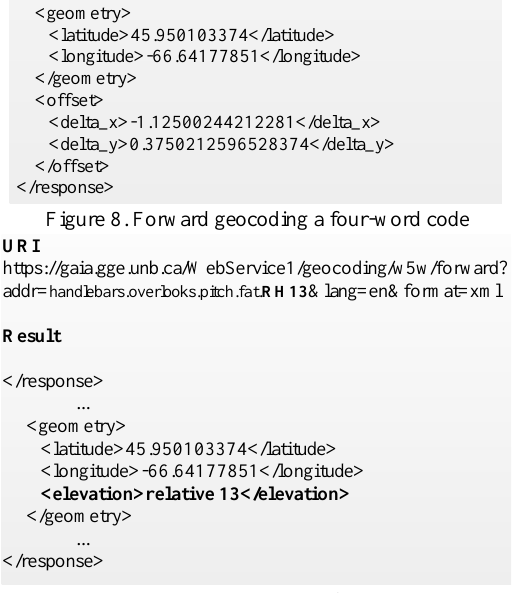
Figure 9. Forward geocoding a five-word